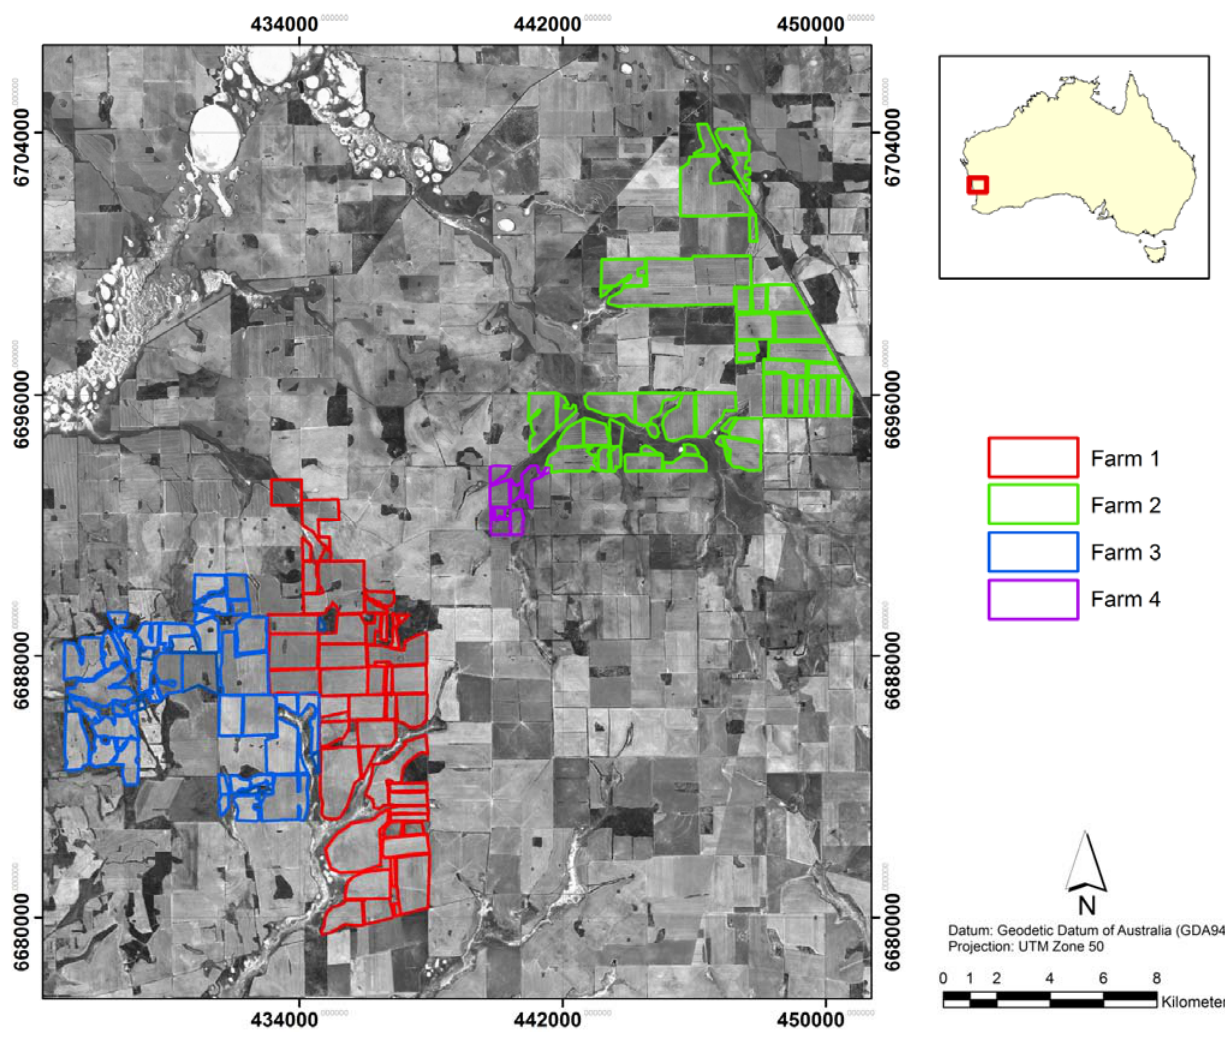
Figure 1. The four farm study area in Western